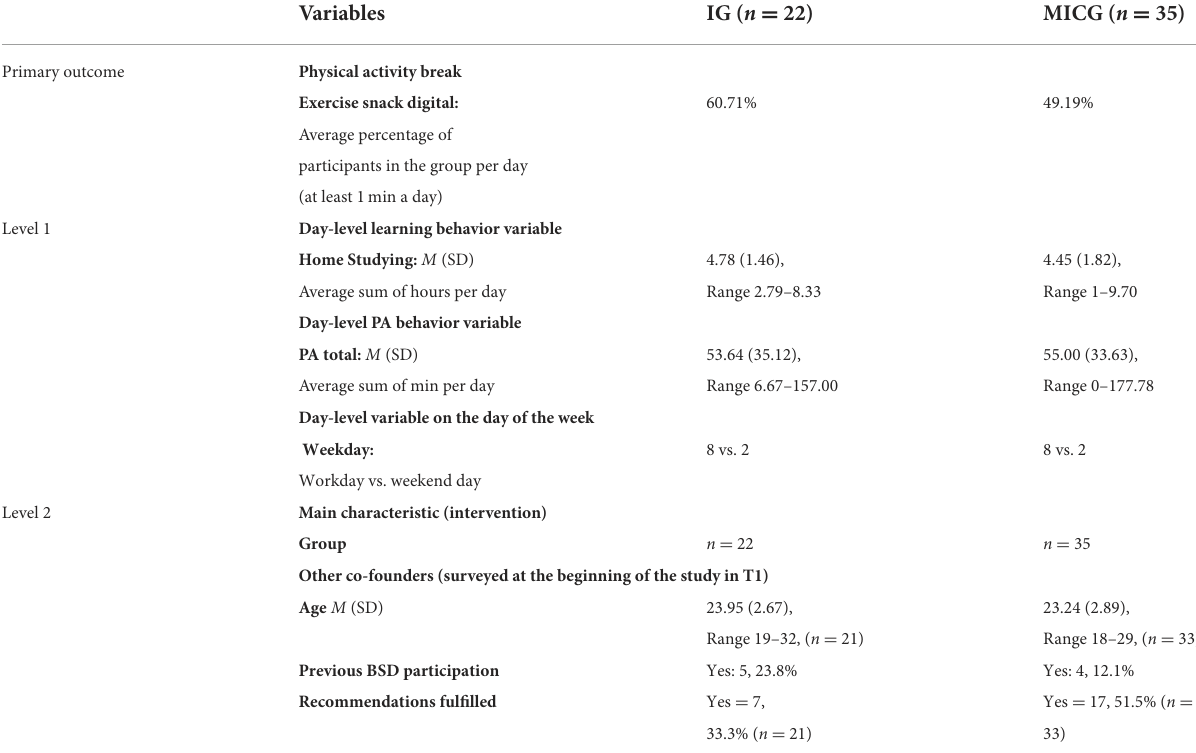
TABLE 1 Description of the variables included in the analysis for both groups (IG, intervention group; MICG, minimal intervention control